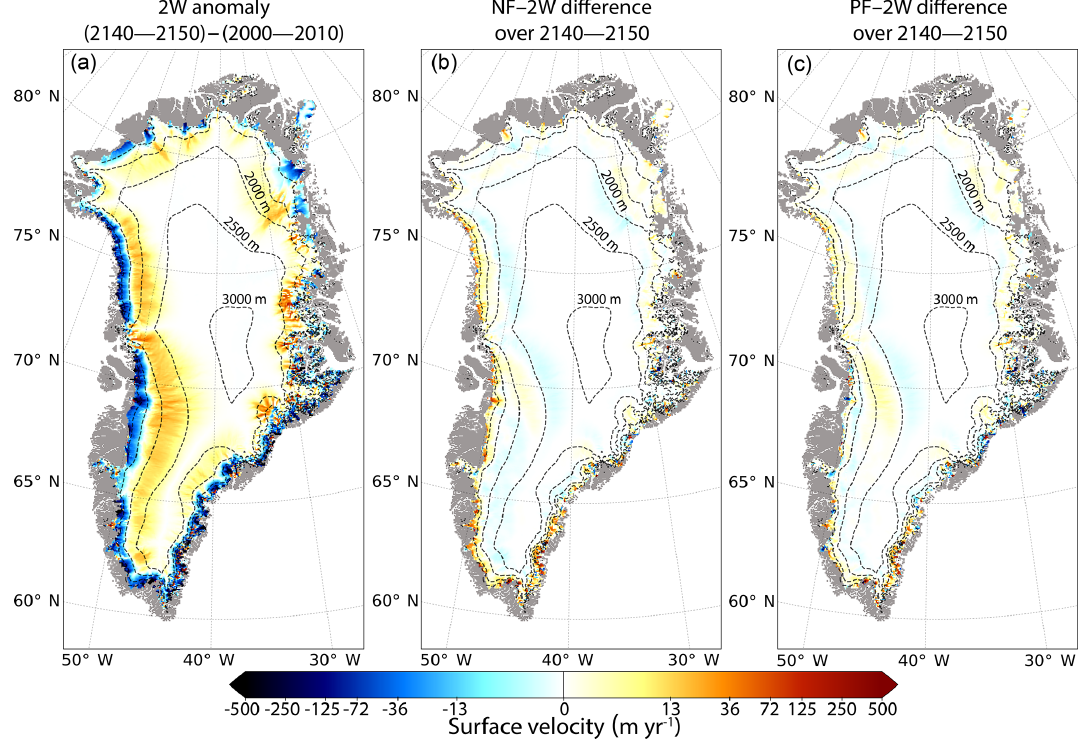
Figure 6. (a) Mean surface velocity anomaly (inm yr − 1 ) between the 2140–2150 and the 2000–2010 mean periods for the 2W experiment. (b) Mean surface velocity difference between the NF and the 2W experiments for the 2140–2150 mean period. (c) Same as (b) for the PF and 2W experiments. These differences are computed on the GRISLI grid. The dashed lines correspond to the 500m surface elevation iso-contours for the present-day observed topography. The grey shading represents the non-ice-covered areas. A non-linear colour scale is used for both positive and negative